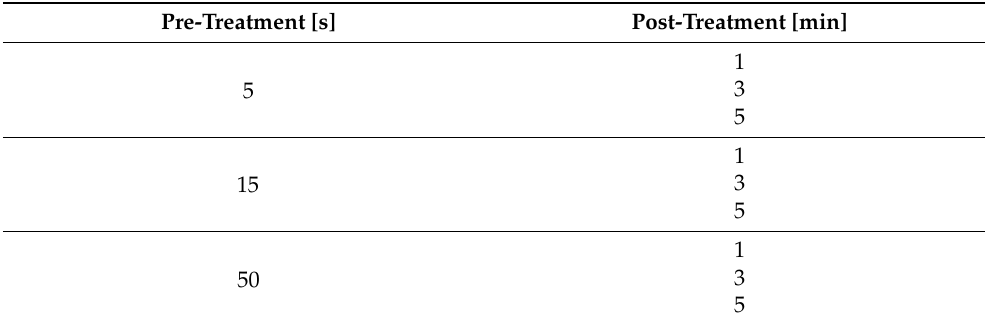
Figure 1. Scheme for the indirect plasma treatment of the samples. It highlights the gas flow and the temperature development throughout the process. The process starts with compressed air that is carried over a plasma torch where it is processed (pre-treatment). Subsequently, the PPA is carried via a scrubber and high-grade steel pipes into the treatment chamber (post-treatment), which offers the possibility for heat dissipation. The temperature is decreased from 4000 K at its production site to approx. 298 K in the treatment chamber. The total power injection of 1.1 kW is divided on both states of the on/off-period. Table 1. Summary of the treatment regime used for the surface decontamination. Every regime is a combination of a pre-treatment for the PPA production and a post-treatment for the surface- decontamination